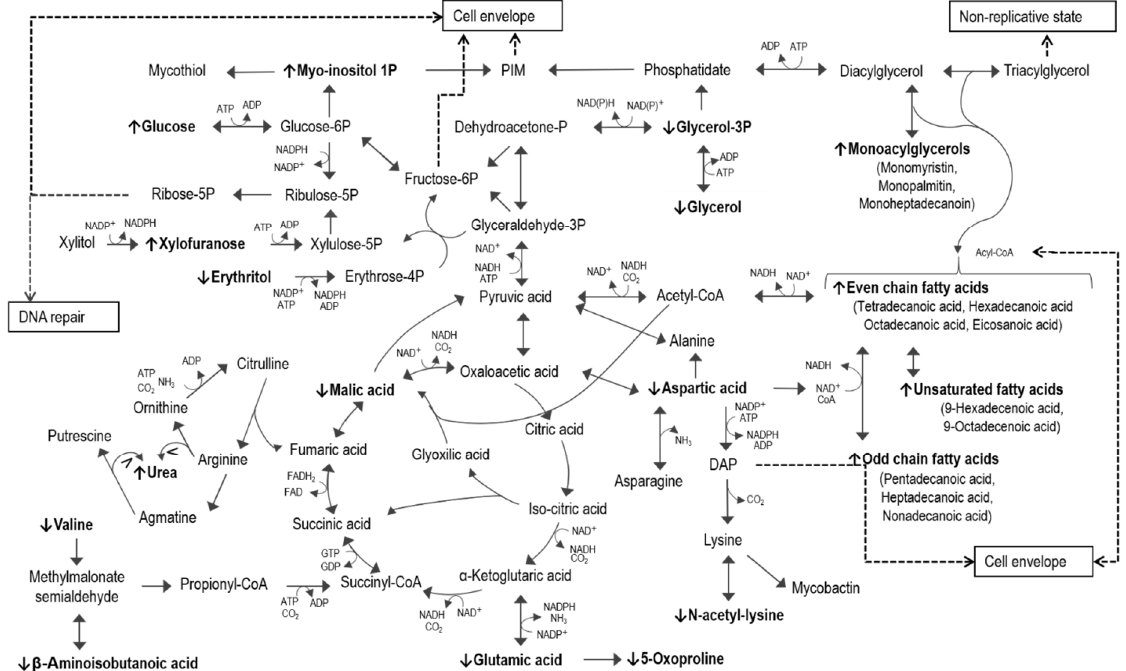
Figure 4. Metabolomic pathway map of Mtb treated with ciprofloxacin. The metabolite markers best describing the variation in the metabolome compared to those of untreated Mtb are represented in bold text with up or down arrows indicating elevated or reduced concentrations, respectively.